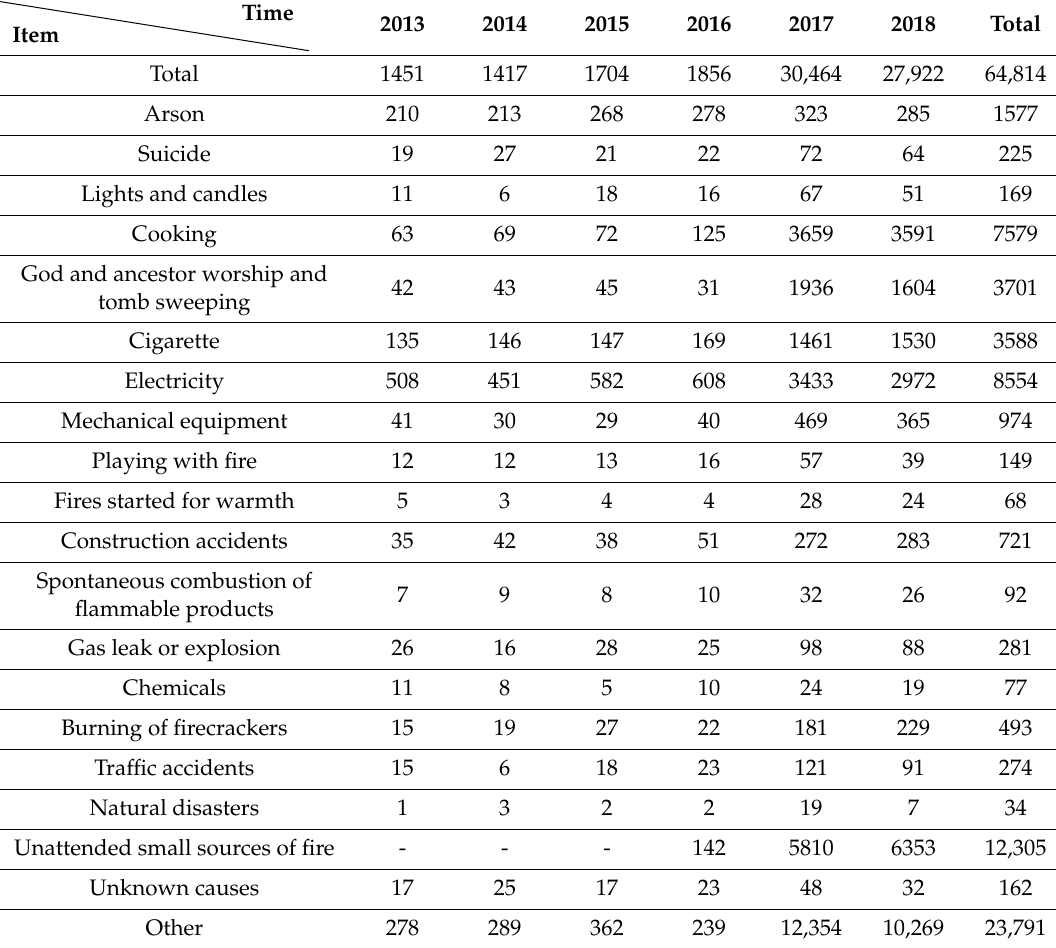
Table 1. Number of fire incidents and fire losses in Taiwan from 2013 to